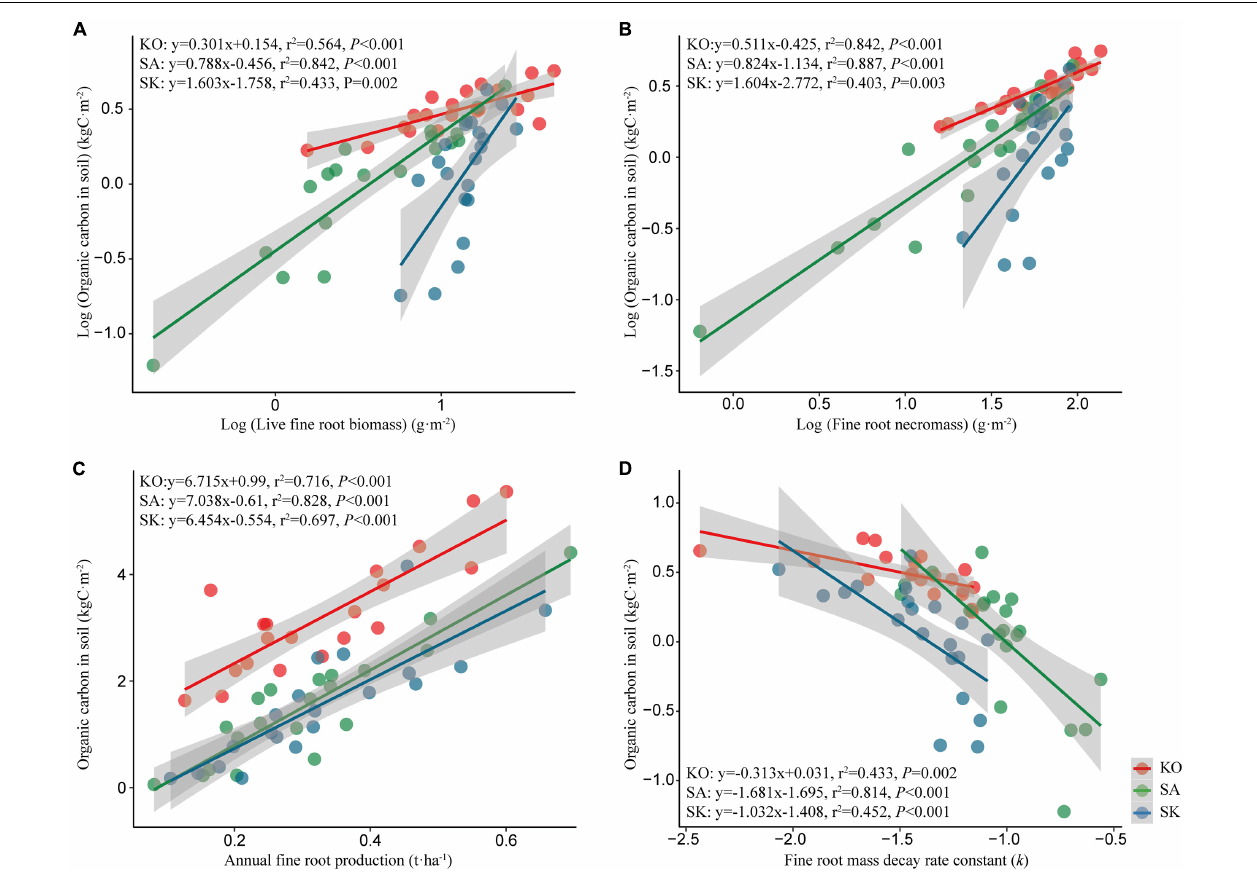
FIGURE 8 | Regression analysis between organic carbon in soil and live fine root biomass (A) , fine root necromass (B) , annual fine root production (C) , and fine root mass decay rate constant (D) for S. apetala (SA), K. obovata (KO) monocultures and the mixed (SK) plantations at Hanjiang River Estuary, south